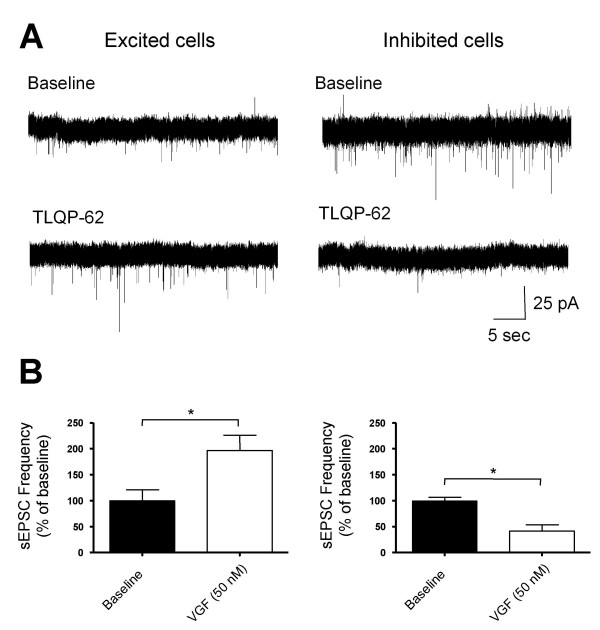
TLQP-62 alters the spontaneous excitability of superficial dorsal horn neurones. sEPSCs were recorded in lamina I and II neurones from P21 spinal cord slices using whole cell patch clamp techniques. Cells were clearly divided in their response to TLQP-62 (50 nM) with 6/9 neurones showing a significant increase in the frequency of sEPSCs while 3/9 cells were significantly inhibited, as illustrated by sample traces (A) and histograms showing the normalised frequency of spontaneous activity before and 10 minutes after TLQP-62 application (B). The effects were classified as inhibitory or excitatory using a Komologorov-Smirnov 2-sample test (P < 0.05) and a t-test was used to compare the population data in B (*P < 0.05).